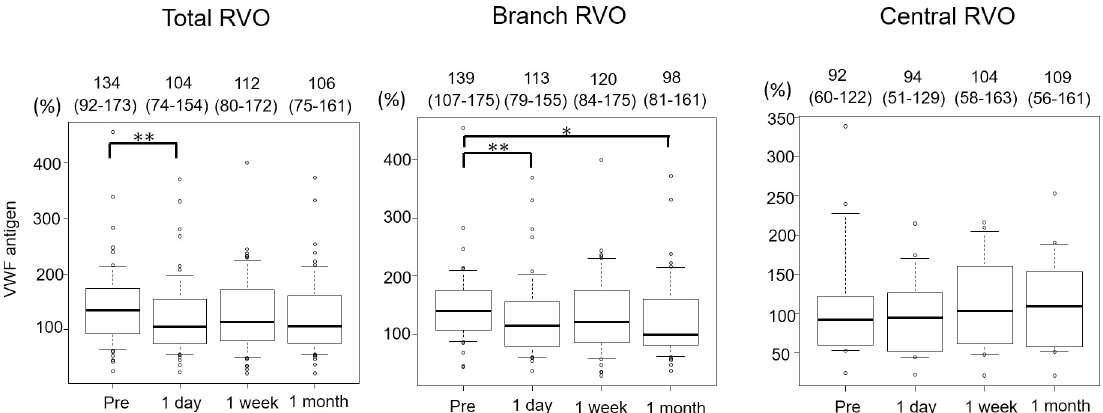
Fig 5. Alterations of VWF antigen after anti-VEGF treatment. Each of the values above the graph presents the median with the interquartile range. � < 0.05, �� < 0.01. RVO, retinal vein occlusion.